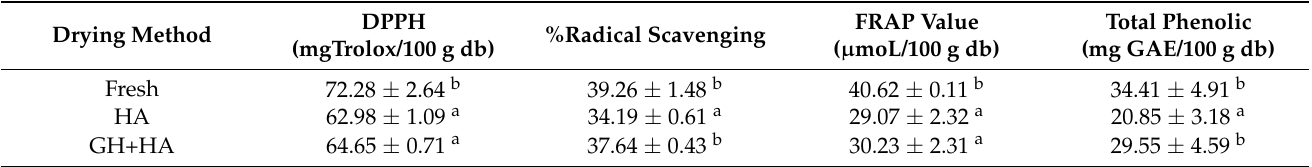
Table 8. Total phenolic and antioxidant activity of fresh and dried mango slices from different drying